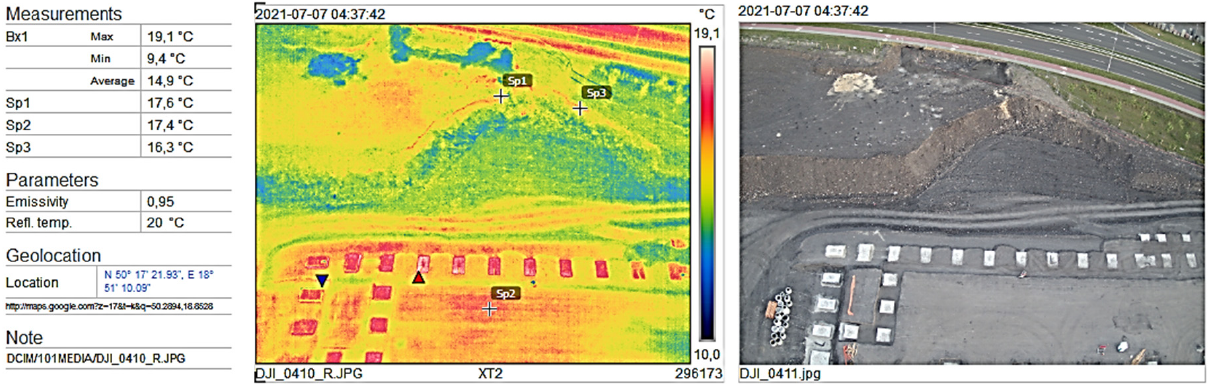
Figure 13. Infrared and visible light imaging—a north-west area of the construction site (own elab- oration).